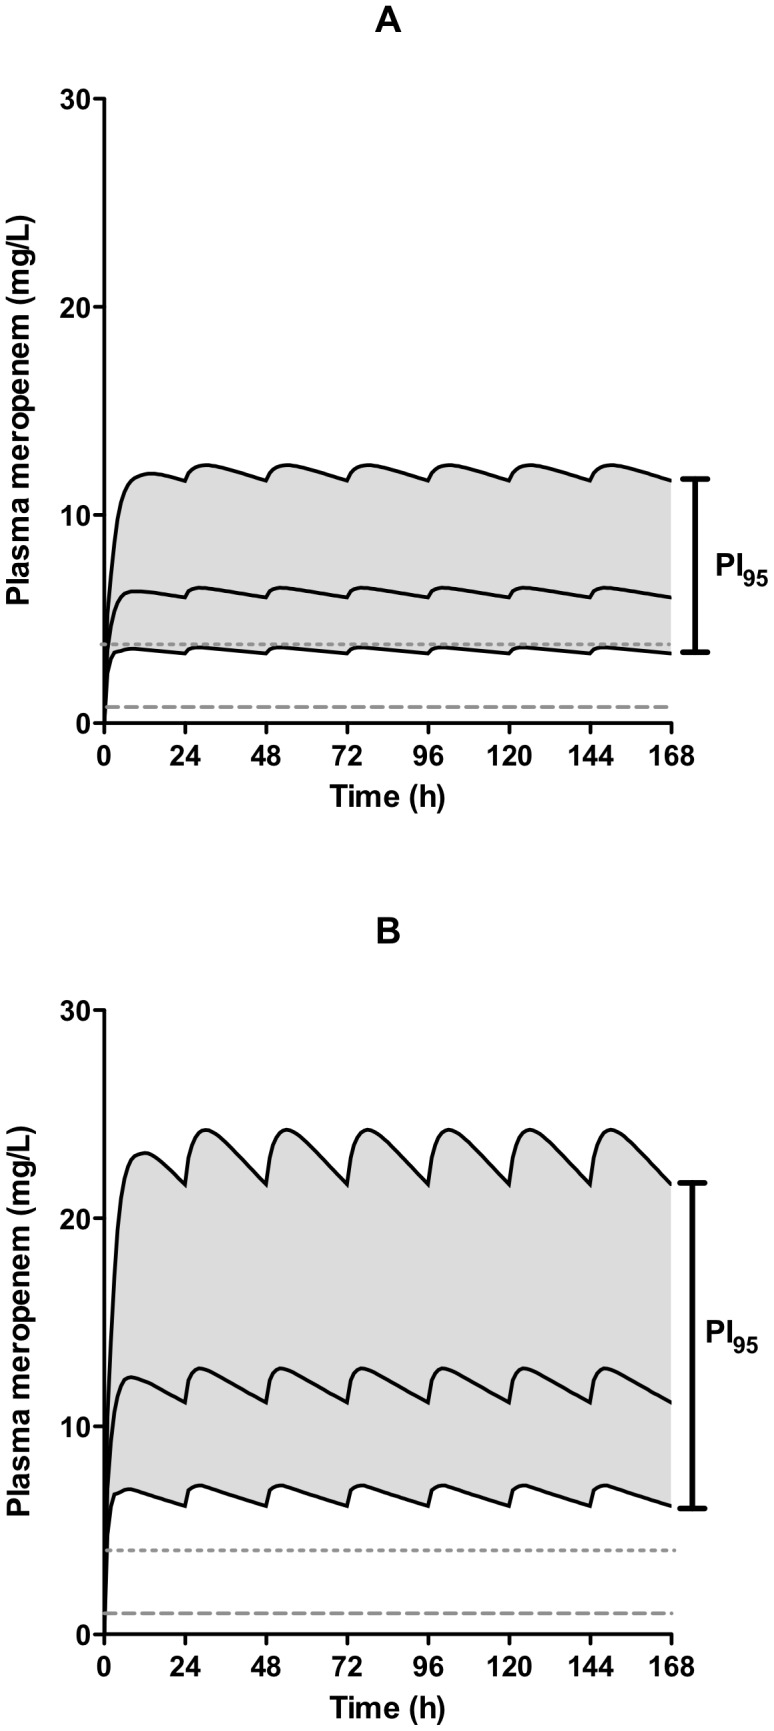
Median and 95% prediction intervals (PI95) of simulated plasma meropenem concentrations incorporating degradation as well as pharmacokinetic variability in 200 simulations of an average, 70 kg male patient receiving meropenem by continuous infusion in a cooled infuser containing 1% meropenem (figure 2A) and ‘room temperature’ infuser containing 2% meropenem (figure 2B).Susceptibility breakpoints for Pseudomonas aeruginosa (upper grey dashed line) and Enterobacteriaciae (lower grey dashed line) are also shown in each.